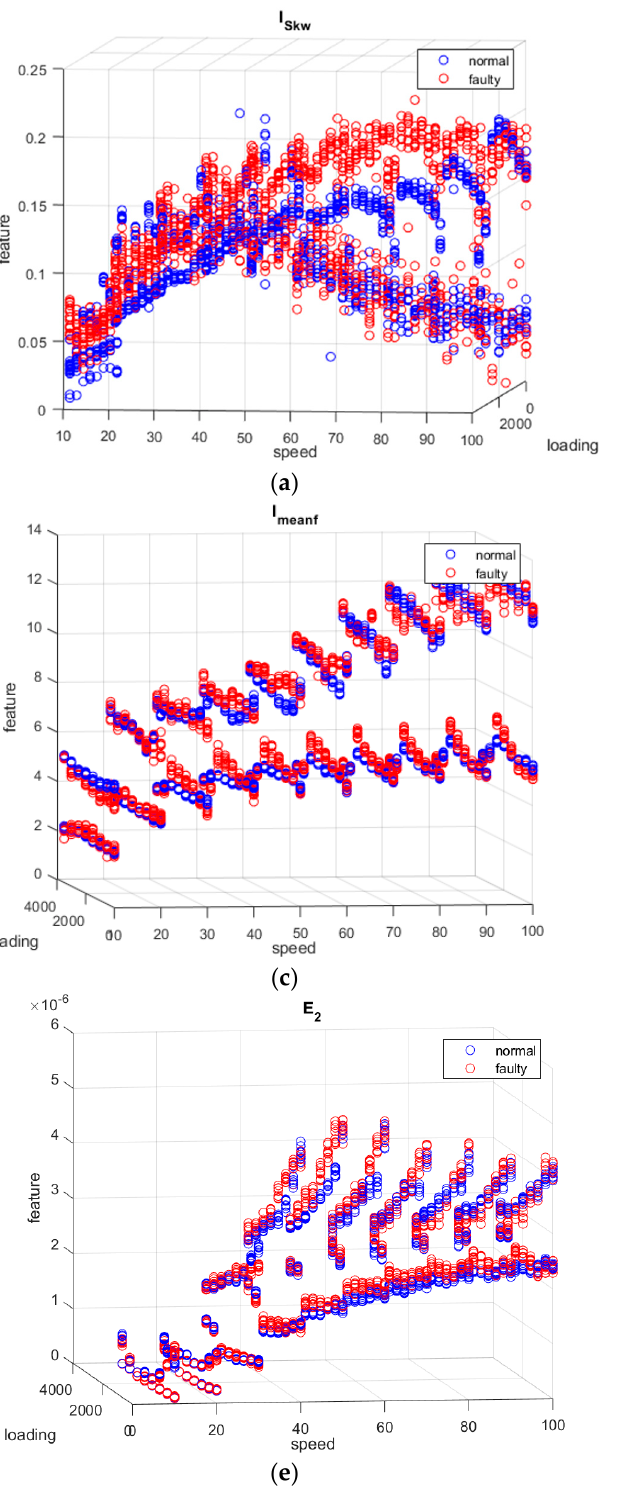
Figure 10. Representative extracted features: ( a ) skewness, ( b ) crest factor, ( c ) mean frequency, ( d ) first energy of WPD, ( e ) second energy of WPD, and ( f ) fourteenth energy of WPD.